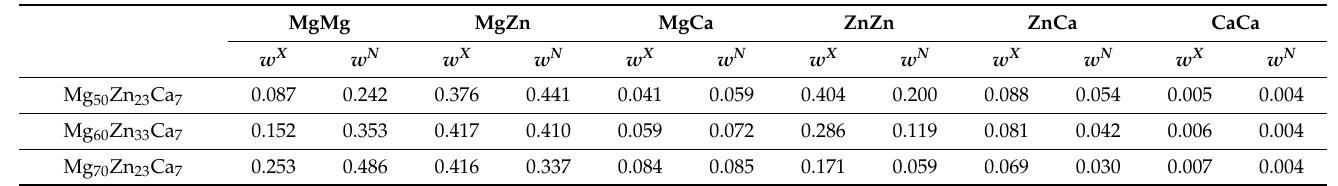
Table 3. X-ray (at Q = 0 Å) and neutron weight coefficients, w X and w N , of each partial reduced